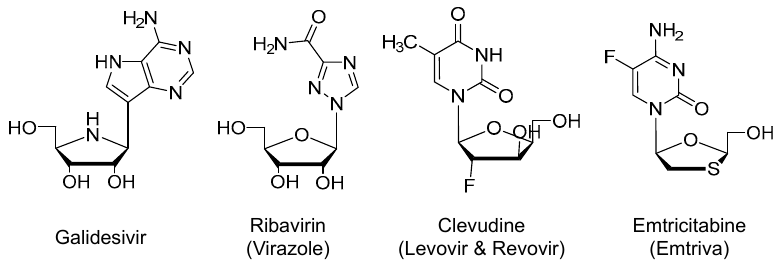
Figure 3. Chemical structures of potential RNA polymerase inhibitors, all of which are nucleoside derivatives that undergo tri-phosphorylation activation to form the corresponding nucleoside triphosphate metabolites as the active forms. Emtricitabine is being tested in COVID-19 patients in combination with tenofovir disoproxil or tenofovir alafenamide. The activation schemes for tenofovir disoproxil or tenofovir alafenamide are provided in the supplementary document.